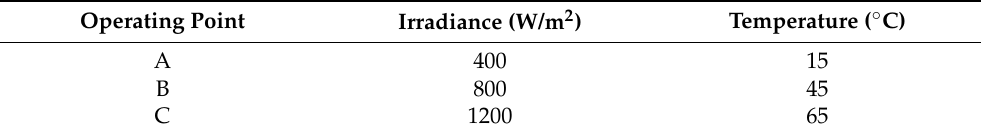
Table 5. Operating conditions.